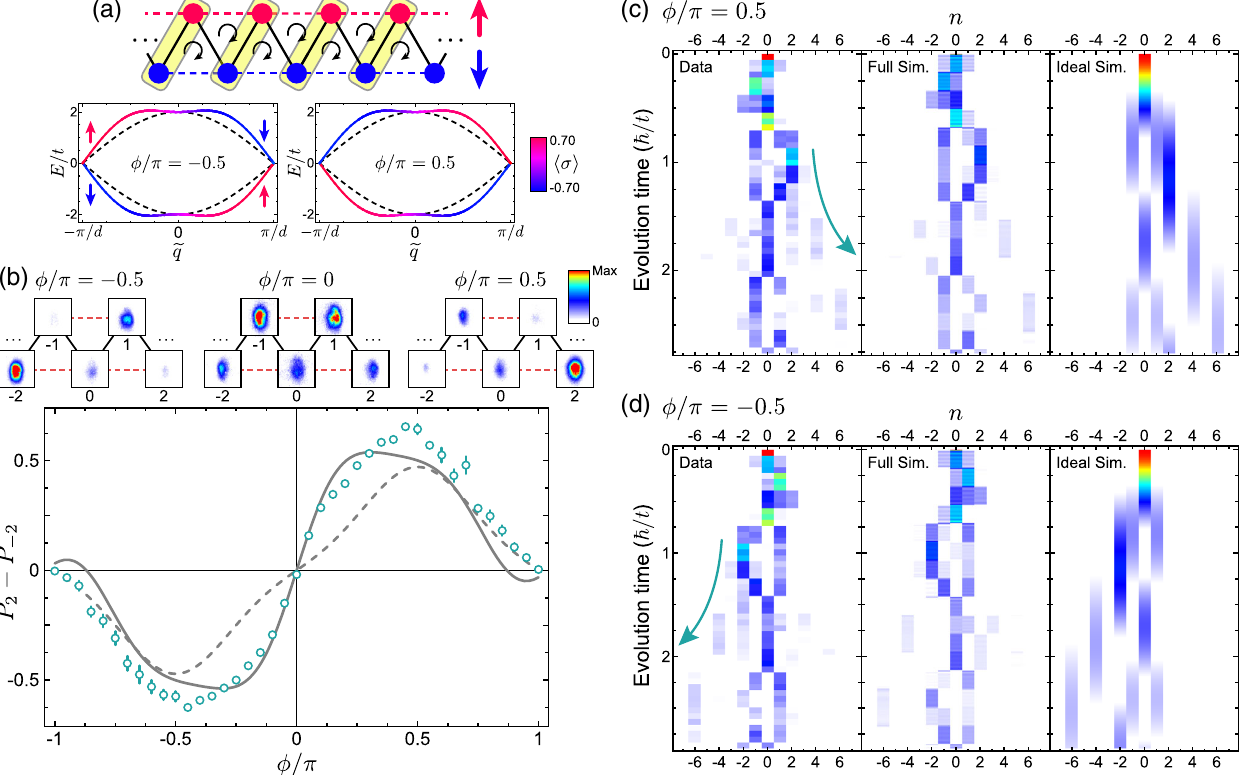
FIG. 2. Chiral dynamics in the zigzag lattice. (a) Band structure for ϕ = π ¼ (cid:2) 0 . 5 considering a two-site unit cell (yellow boxes in lattice illustration), for tunneling ratio t 0 =t ¼ 0 . 62 . Color represents spin polarization h σ i , or the overlap of the quasimomentum eigenstate with the top (red, spin up) or bottom (blue, spin down) row of the lattice. Dashed black curves represent the folded band structure for t 0 =t ¼ 0 . ˜ q should be considered “ quasiposition ” in our momentum-space lattice and is given in terms of the unit cell lattice spacing d ¼ 4 ℏ k . (b) Population imbalance between sites 2 and − 2 of the 21-site lattice, measured after 180 μ s of dynamics ( ∼ 1 . 05 ℏ =t ) with optical density (OD) images of atomic populations at ϕ = π ¼ 0 , (cid:2) 0 . 5 above. Dashed and solid curves represent an ideal simulation of the experiment using Eq. (1) and a full simulation of experimental parameters, respectively. (c),(d) Site population dynamics for applied flux (c) ϕ = π ¼ 0 . 5 and (d) ϕ = π ¼ − 0 . 5 . Left to right: data, full simulation, and ideal simulation of experiment. Arrows indicate direction of chiral motion. Data for (b) – (d) were taken with averaged NN tunneling time ℏ =t ¼ 176 ð 2 Þ μ s and tunneling ratio t 0 =t ¼ 0 . 622 ð 3 Þ . All error bars denote 1 standard error of the mean. OD images in (b) and extracted site populations in (c) and (d) are plotted with the color scale in